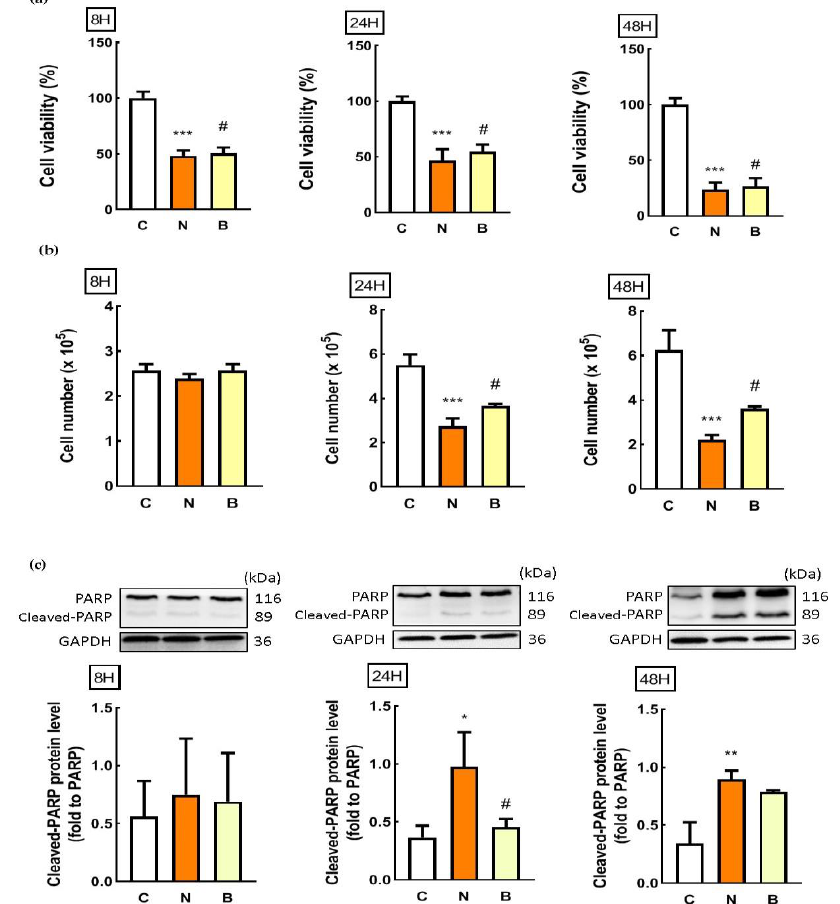
Figure 1. Effect of β -hydroxybuterate on glucose-deprivation-induced Neuro-2a cell death. Neuro-2a cells were cultured in glucose-containing basal conditions (C group), or in the condition of glucose deprivation with (B group) or without the presence of 10 mM β -hydroxybutyrate (N group) for 8, 24, and 48 h. Cell viability and counting was determined by ( a ) MTT and ( b ) trypan blue assays, respectively. Data are means ± SEM of 4–6 independent experiments, each with six replicates. Whole cell lysates from all conditions were subjected to Western blot analysis for the detection of ( c ) cleaved-PARP protein expression. Representative Western blot images are shown. GAPDH was used as the loading control. Data are means ± SEM of 4–6 independent experiments, and each experiment was performed in simplicate. Statistical analysis was performed with one-way ANOVA followed by a Tukey’s HSD post hoc test. *, p < 0.05; **, p < 0.01; ***, p < 0.001 compared with the control group. #, p < 0.05 compared with the N group.